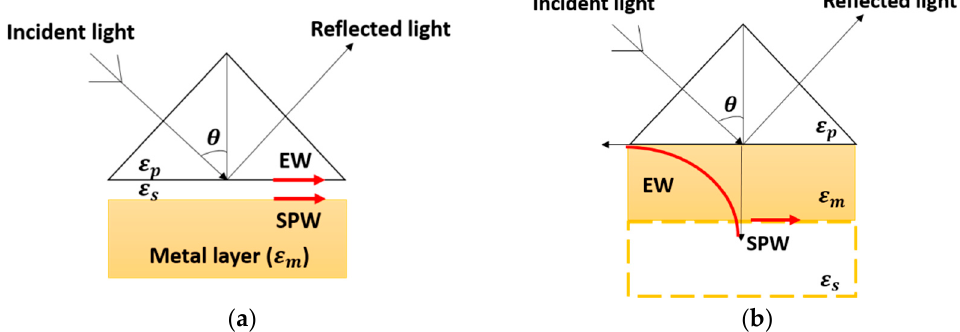
Figure 4. ( a ) Otto configuration and ( b ) Kretschmann configuration for the excitation of surface plasmon at the metal ‒ dielectric interface [23].